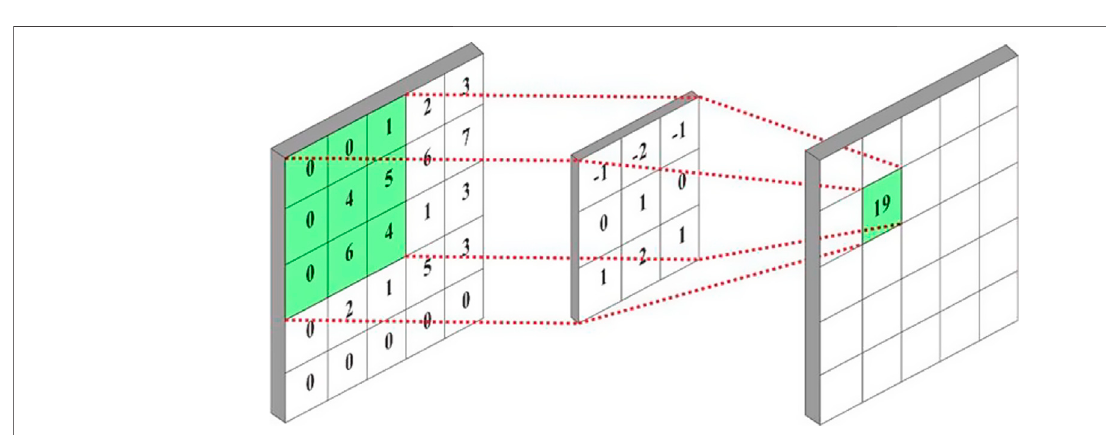
FIGURE 4 | Schematic diagram of the convolutional neural network framework.